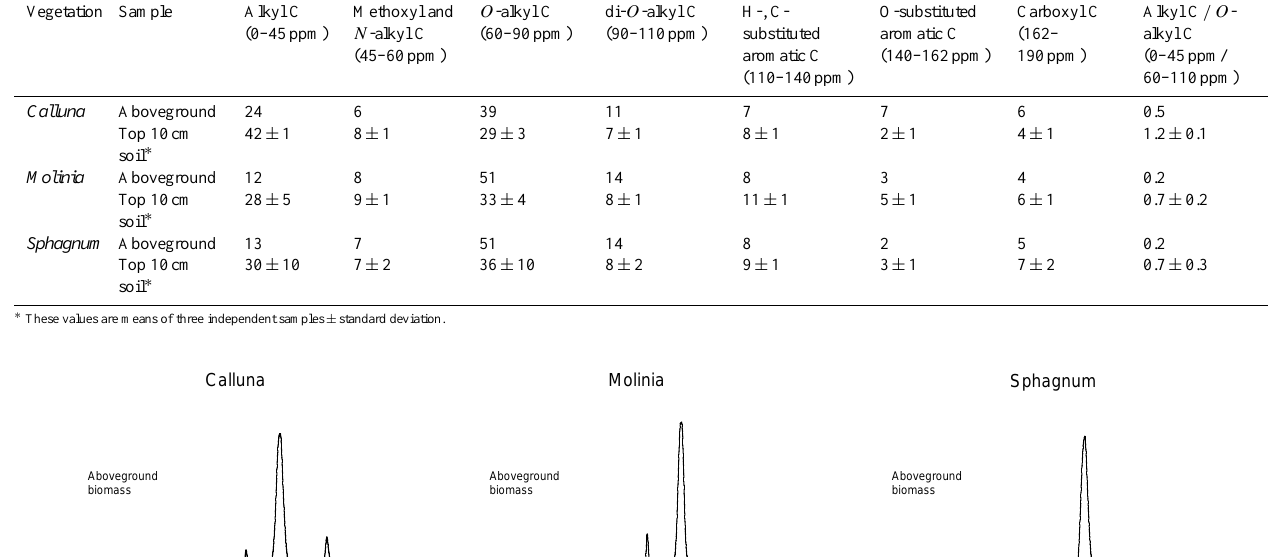
Table 3. Relative intensities, expressed as percent of total area between 0 and 190ppm, of seven main chemical shift regions of CP MAS 13 C NMR spectra and the ratio between the alkyl C and the O -alkyl C-related signals for aboveground vegetation and topsoil. Vegetation Sample